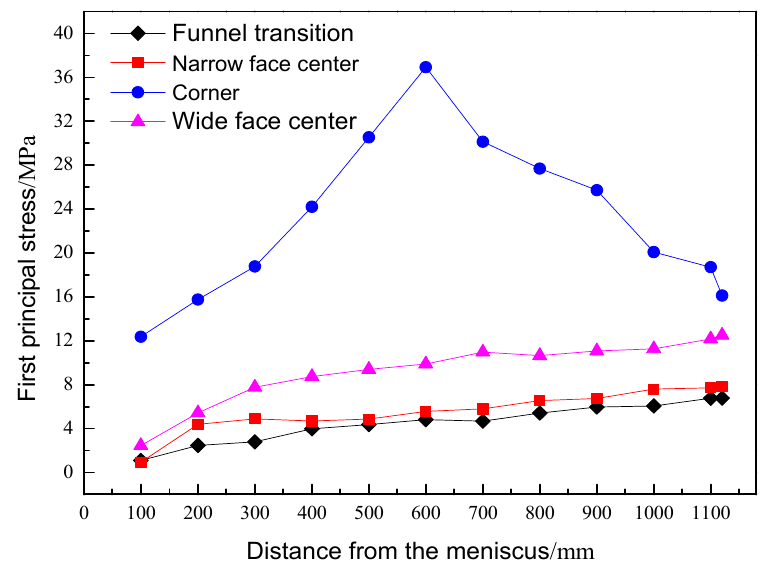
Figure 7. Variation rule of first principal stress of shell in typical